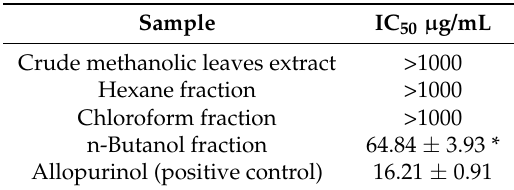
Table 3. IC 50 for xanthine oxidase inhibitory activity of Averrhoa bilimbi crude methanolic leaves extract and its